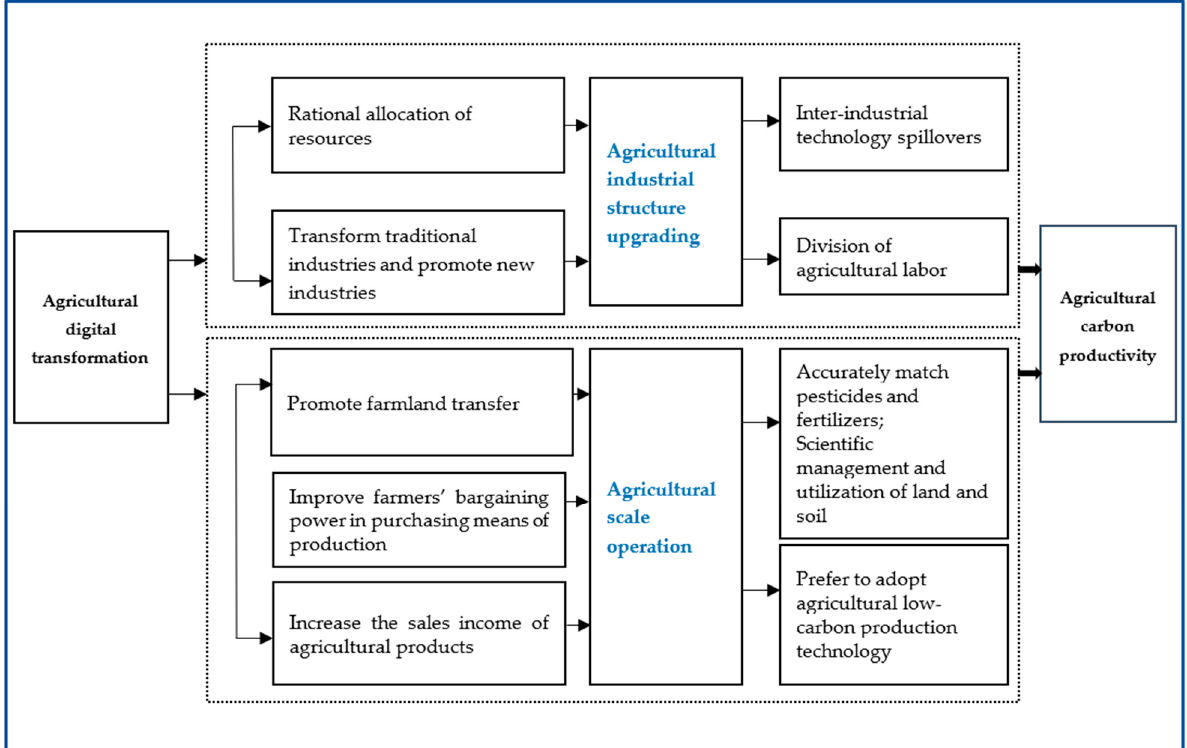
Figure 1. The conduction mechanism of agricultural digital transformation affecting the ACP.